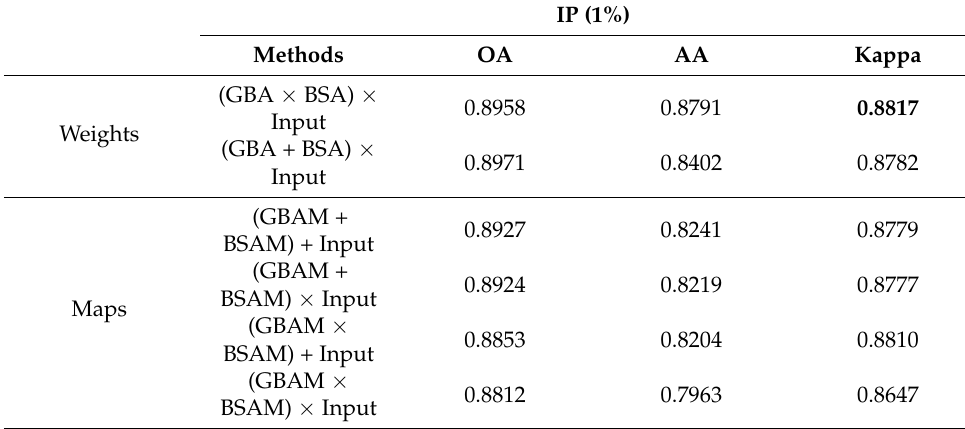
Table 9. The effect of multi-attention fusion strategy on the IP